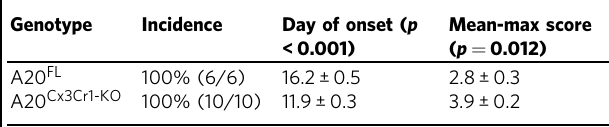
and A20 Cx3Cr1KO littermates showing disease incidence (at least a score of 2), day of onset and mean maximal clinical